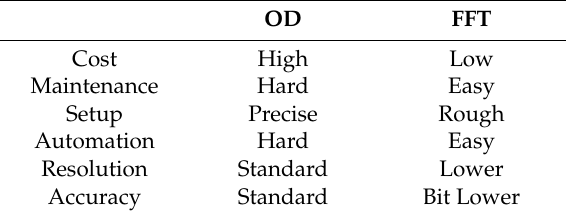
Table 1. Summarized differences between OD- and FFT-based growth detection.